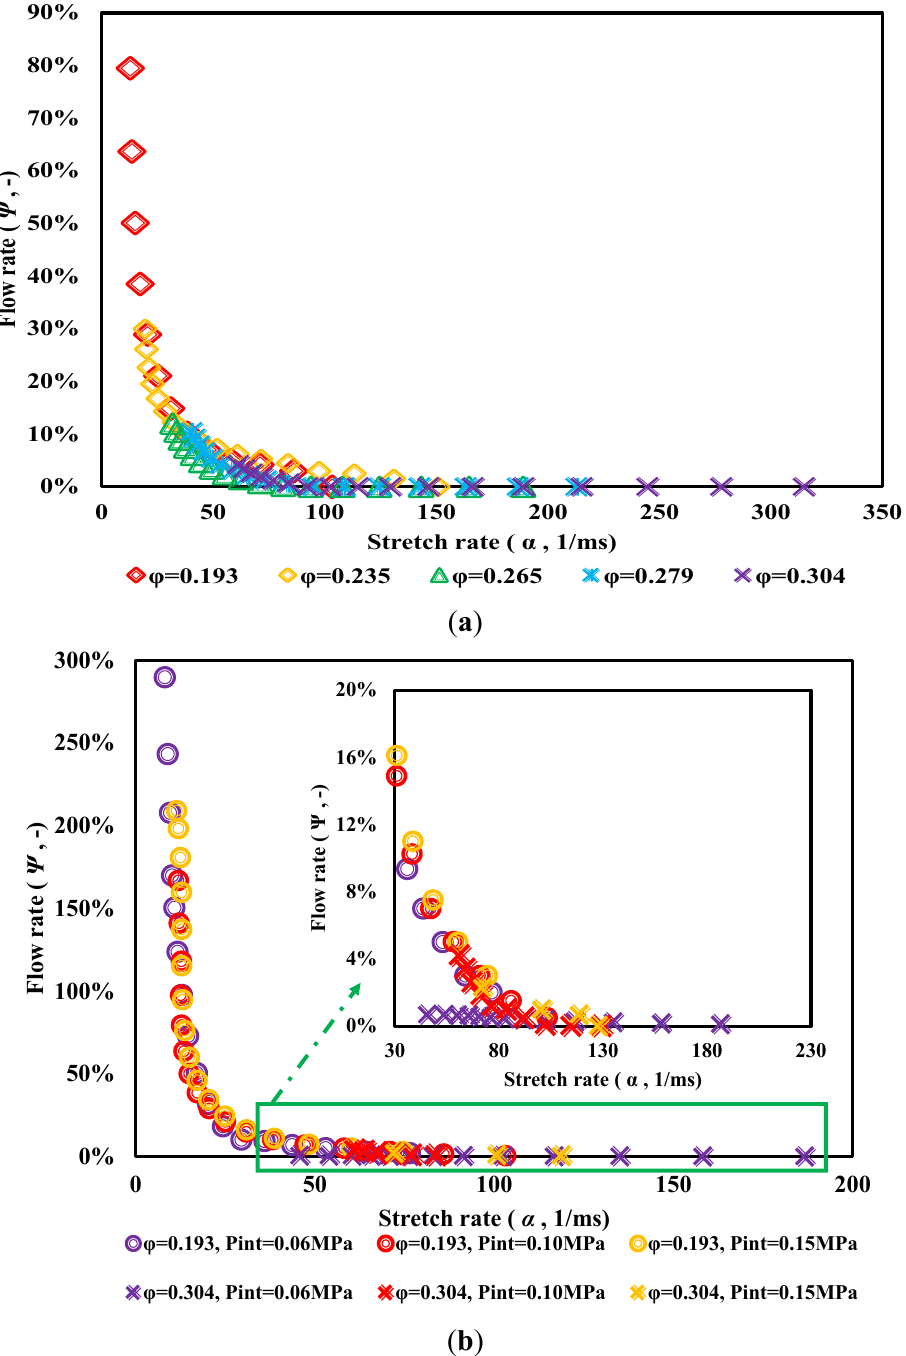
Figure 12. Flow rate of hydrogen-air premixed flames with global stretch rate: ( a ) with different equivalence ratios under atmospheric pressure; ( b ) with φ = 0.193 and φ = 0.304 under different initial